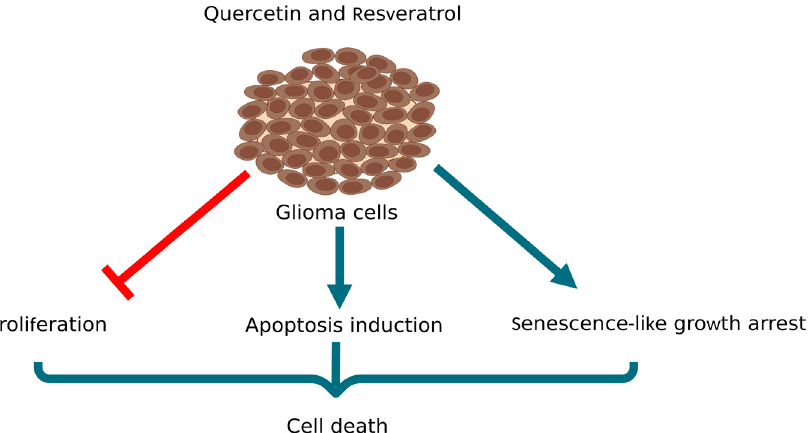
Figure 7. The combination of Que with sodium butyrate in rat C6 and human glioblastoma cells increased apoptosis by inhibition of protective autophagy [102] (created with www.biorender.com; 26 February 2023).